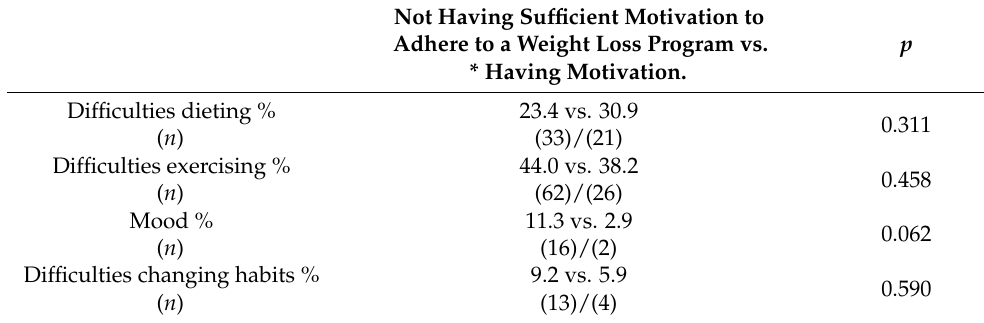
Table 5. Relationship between limiting factors and motivation to lose weight. Not Having Sufficient Motivation to Adhere to a Weight Loss Program